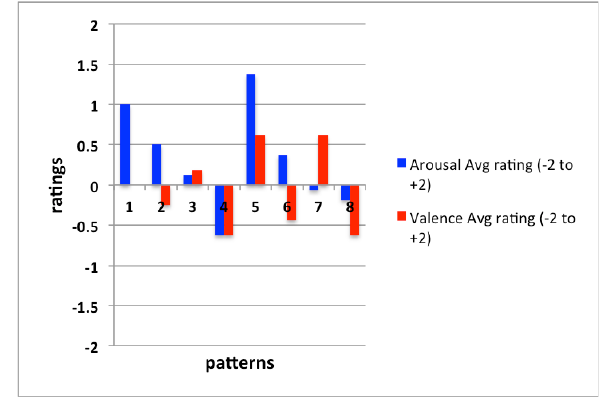
Figure 3. Graph representing the arousal and valence average ratings. Figure 1.